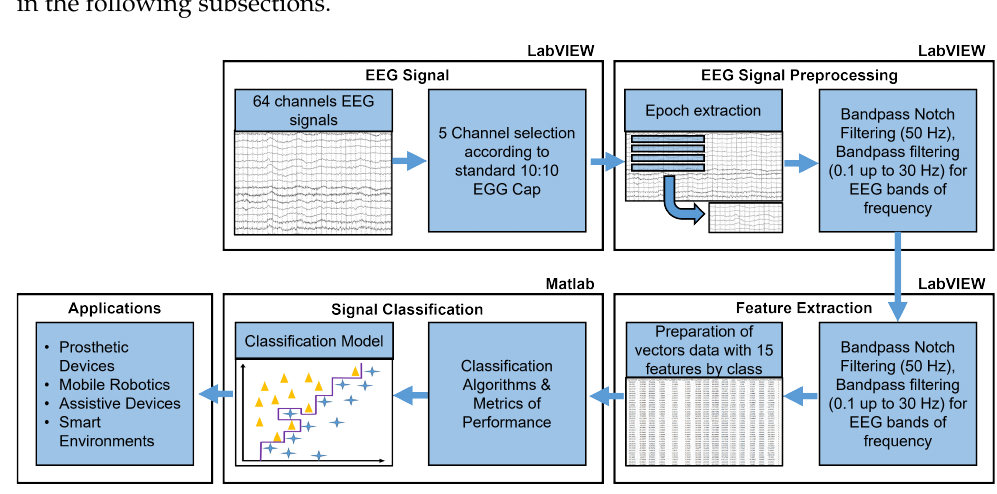
Figure 3. Proposed method for EEG signal